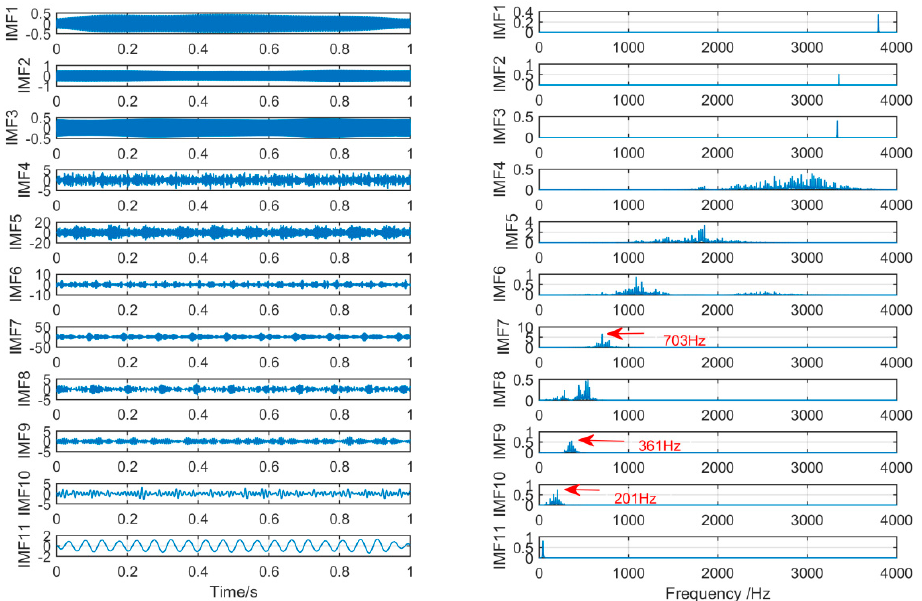
Figure 16. Amplified spectrum of Figure 15.